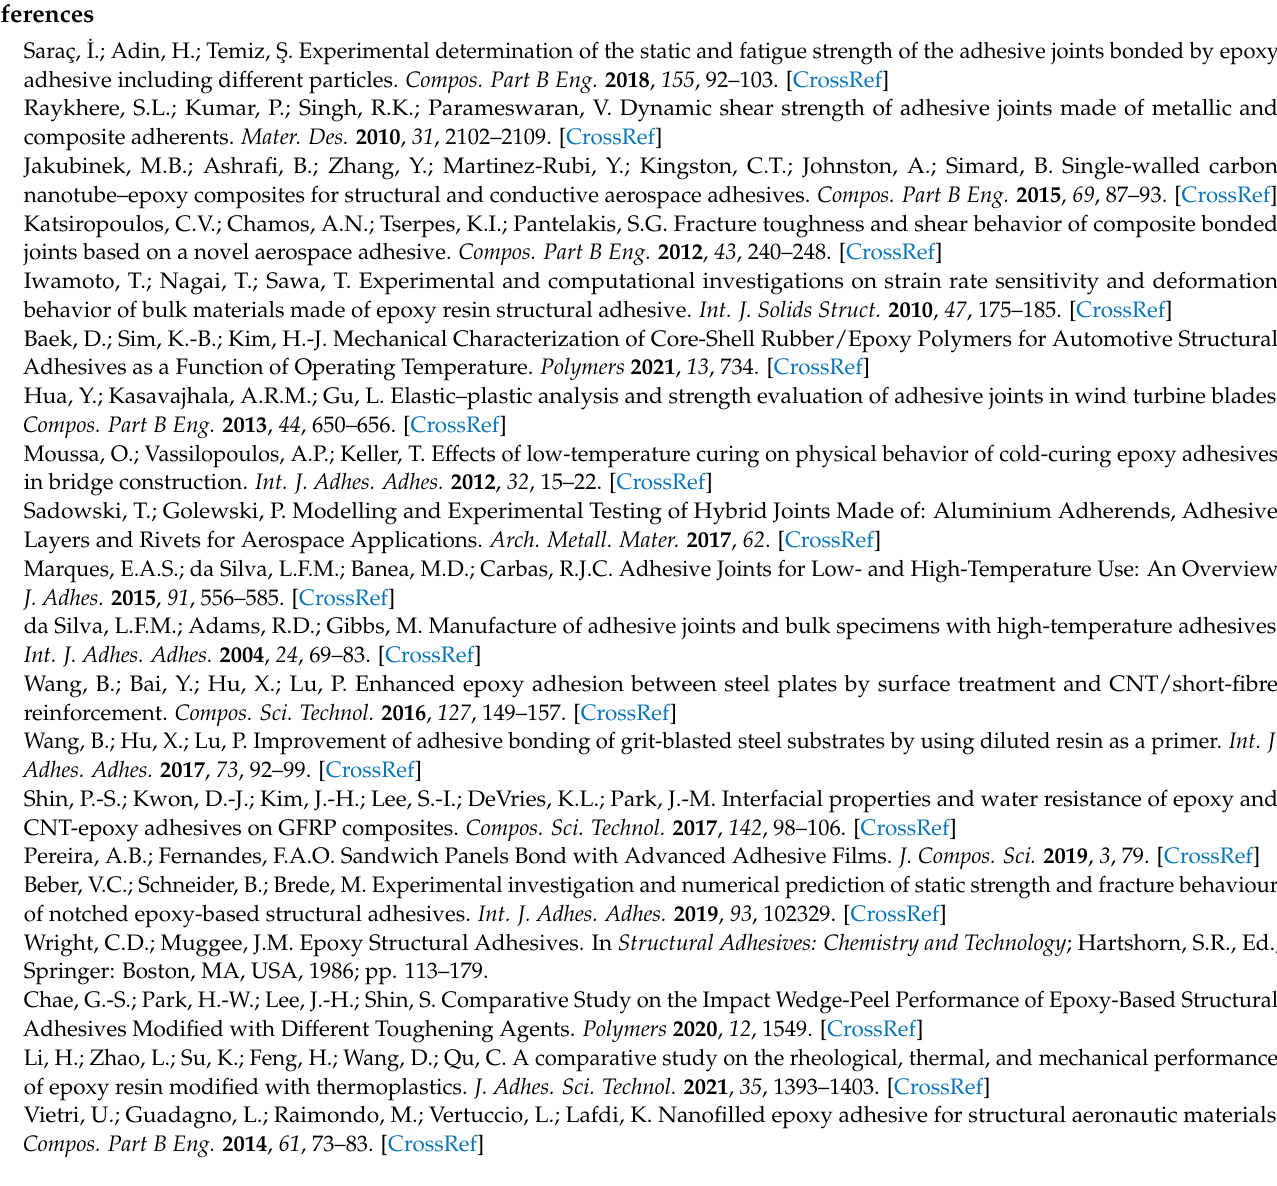
Table S1: Heat capacity, thermal diffusivity, density, and thermal conductivity of the modified adhesive